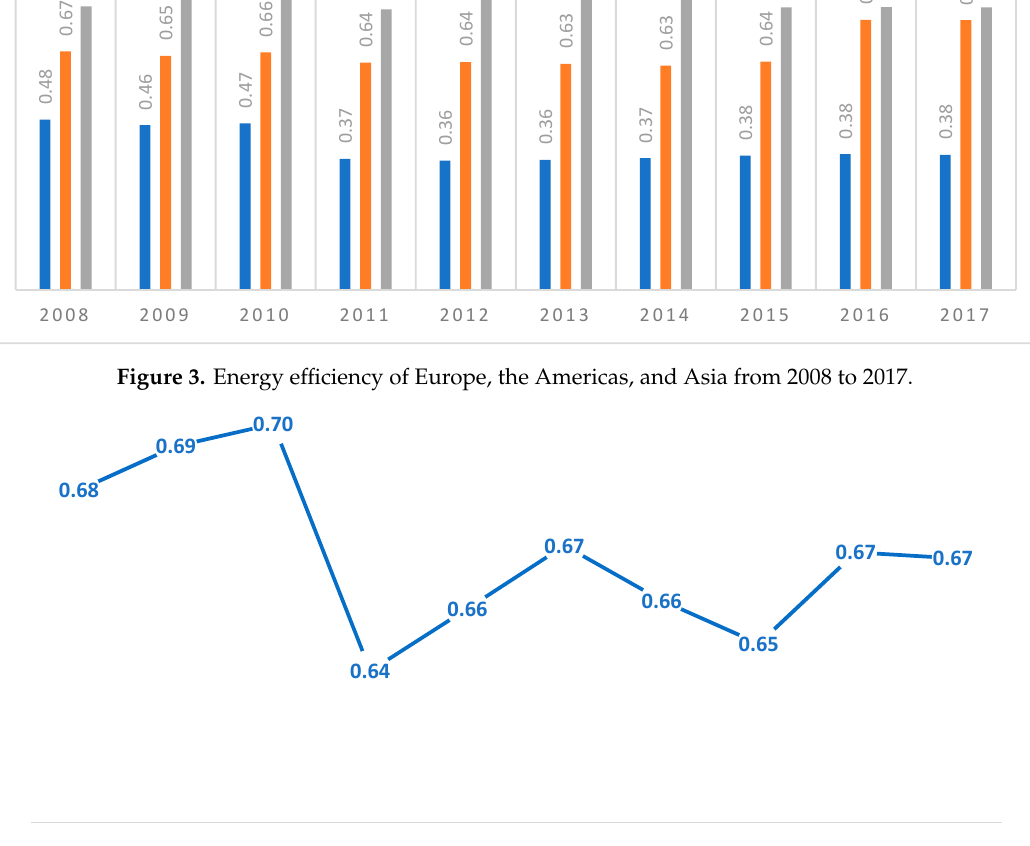
Figure 4. Average energy-efficiency score of the 25 countries from 2008 to 2017.